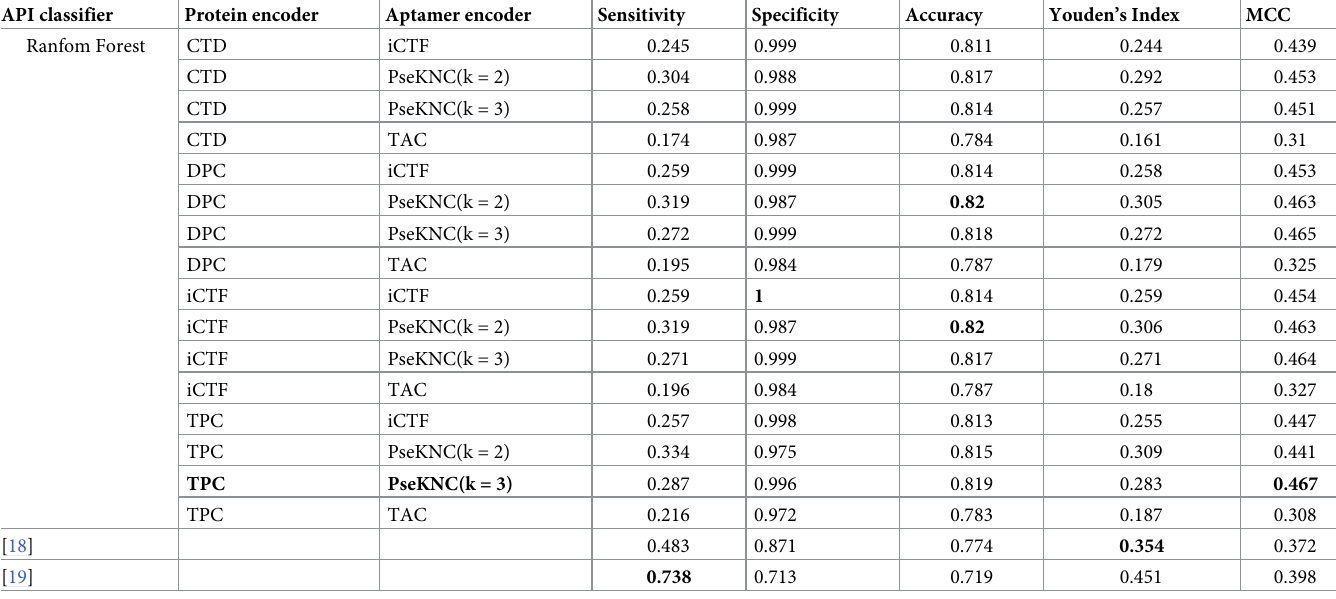
Table 3. Performance evaluation of various input encoding methods using the dataset of Li et al . [18].